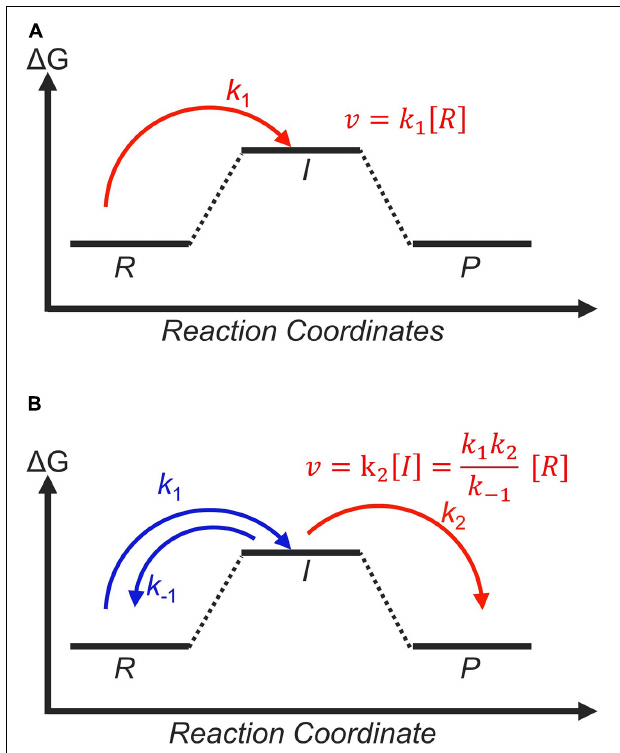
FIGURE 9 | Catalysts with the same thermodynamic free-energy landscapes can still yield different experimental activities, depending on whether the first (A) or the second (B) step determines the catalytic rate. This is governed by the transition state with highest free energy, indicated in red. The corresponding rate equation are shown in both panels, with [R] and [I] corresponding to the concentrations of the reactant and intermediate, respectively. Rate constants are according to usual nomenclature, where k 1 is for the formation of the intermediate, k 2 is for the formation of the product, and negative signs indicate reverse